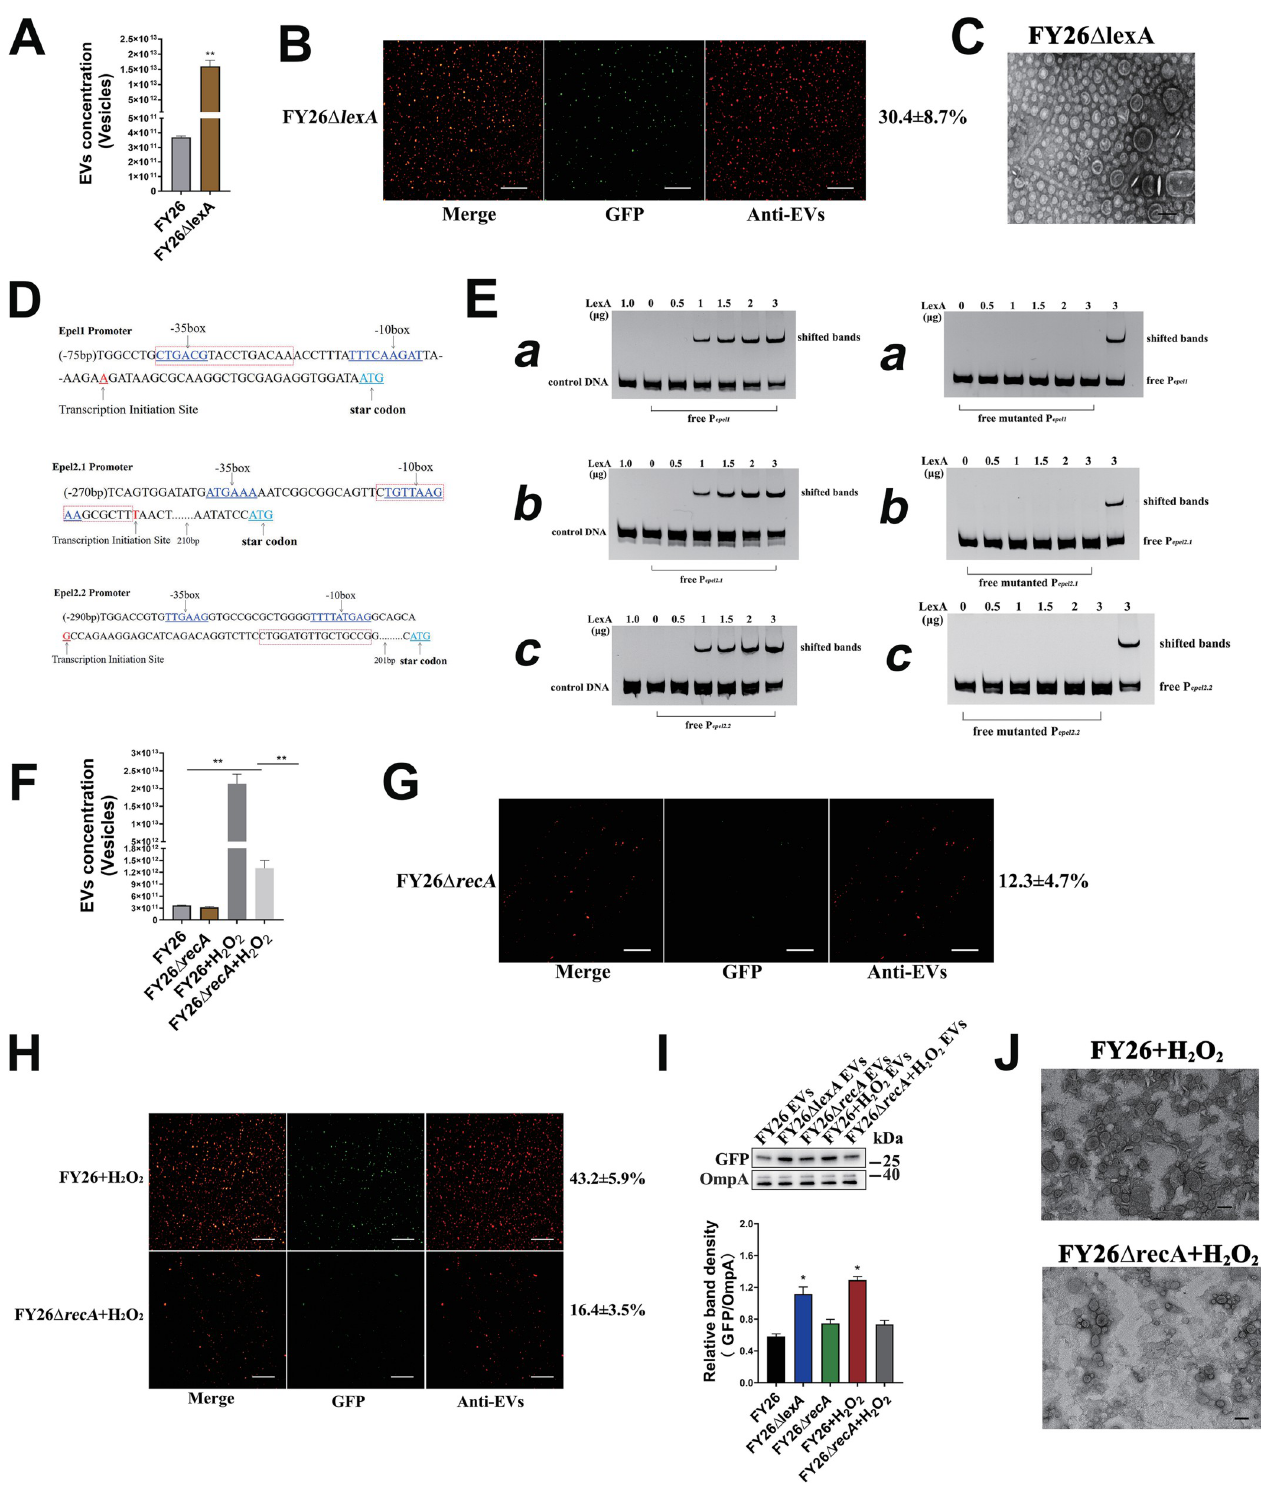
Fig 8. SOS response promotes the formation of ExPEC cytoplasm-carrying vesicles. (A) The concentration of purified EVs produced by FY26 Δ lexA were determined with a nanoparticle tracking analysis (NTA). (B) Immunofluorescent staining of EVs produced by FY26 Δ lexA . (C) The EVs produced by FY26 Δ lexA were observed with transmission electron microscopy (TEM). Scale bars: 200 nm. (D) Schematic diagram of transcriptional promoter regions